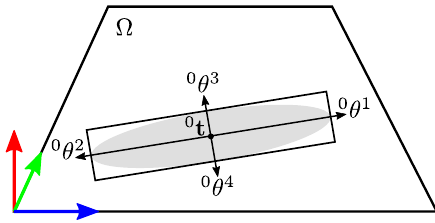
Figure 4. Initialisation of the model particles.